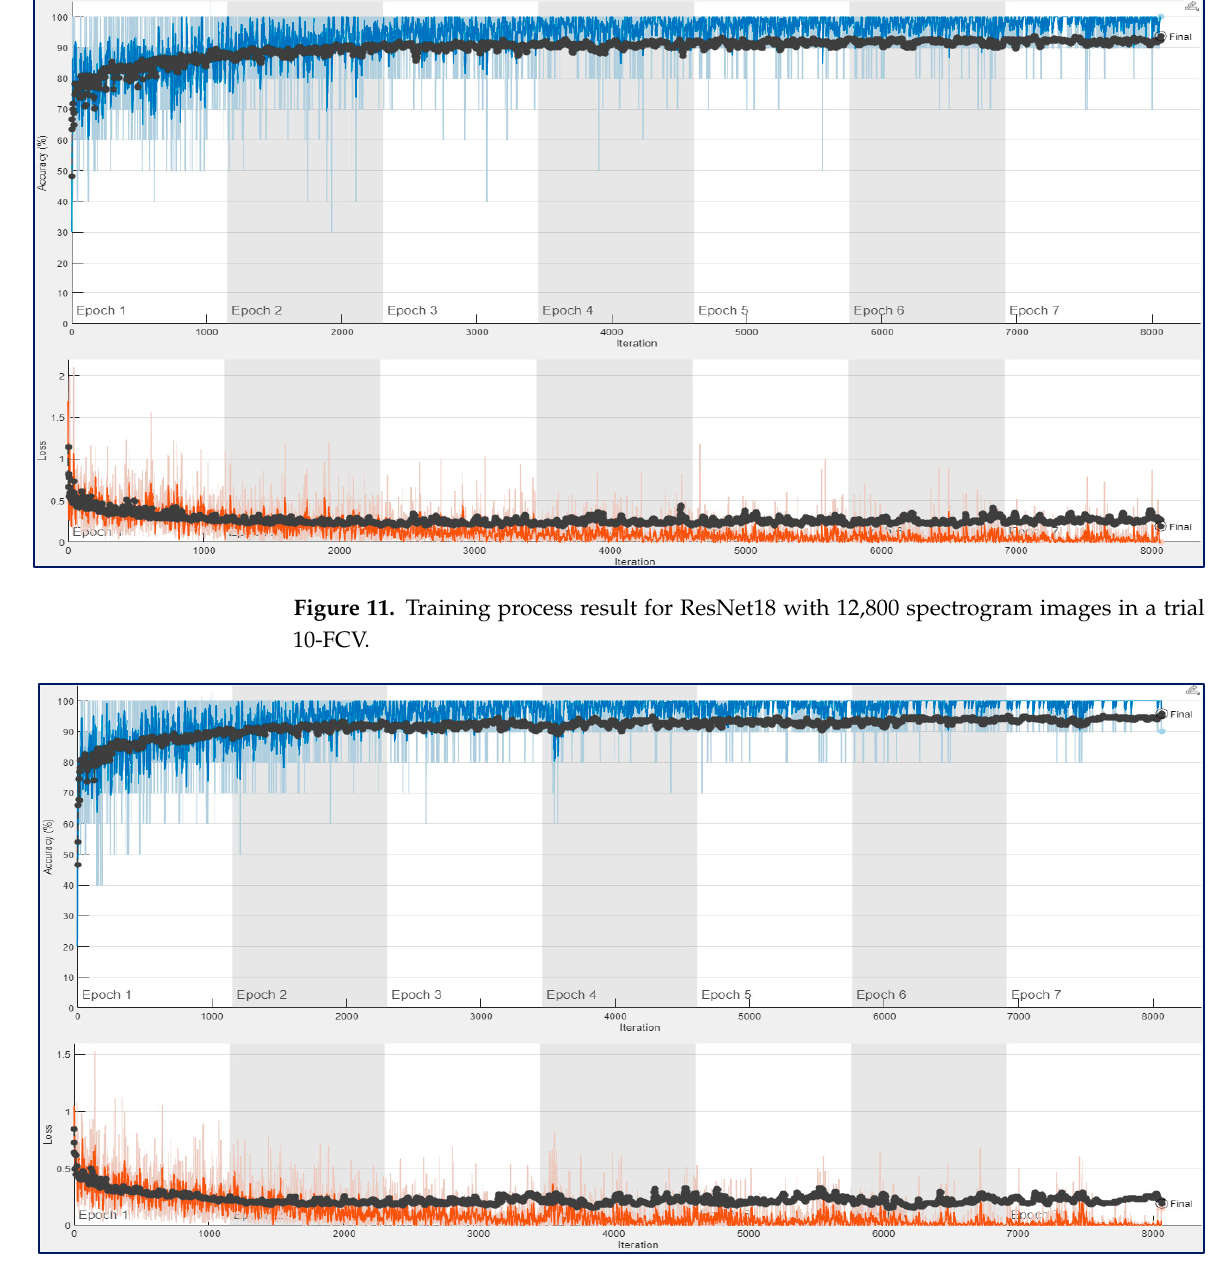
Figure 12. Training process result for ResNet50 with 12,800 spectrogram images in a trial on the 10 ‐ FCV.